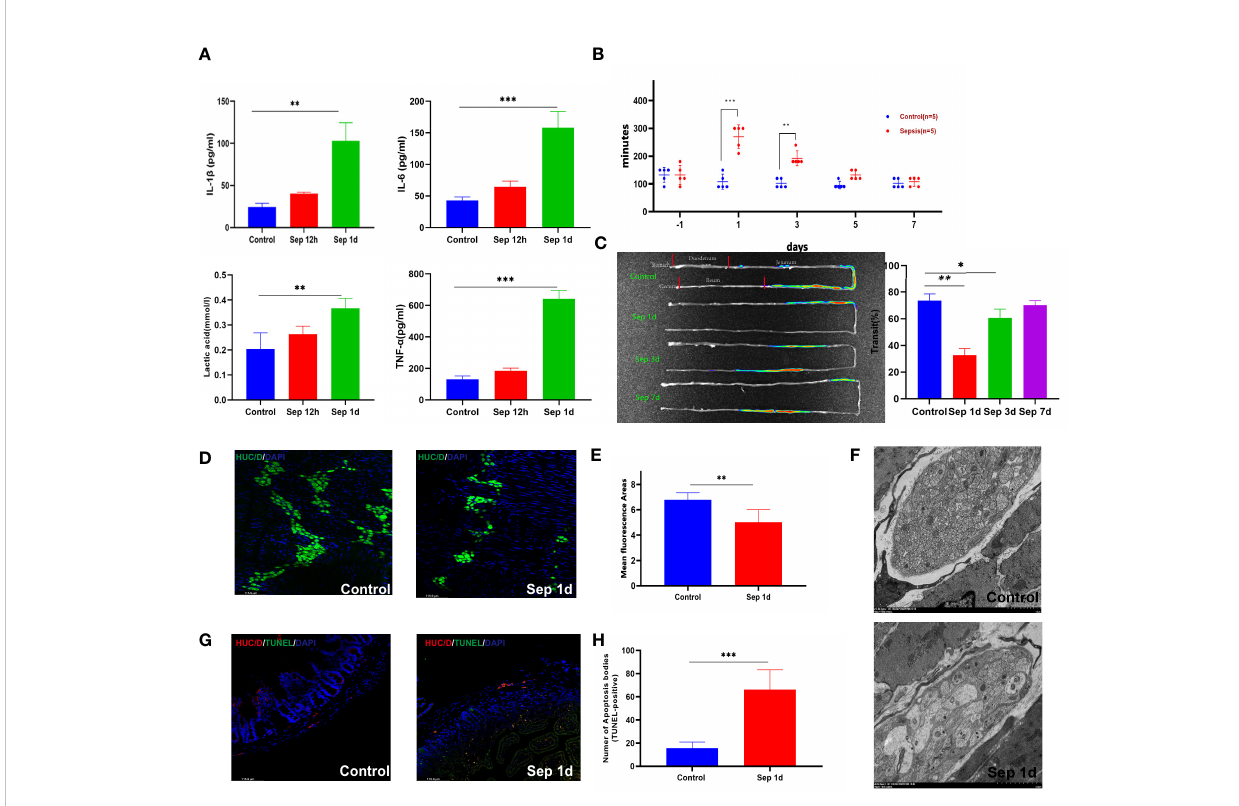
FIGURE 1 Changes after manipulation of Klebsiella pneumonia (KP)-sepsis mice. (A) Changes in plasma IL-6, IL-1 b , TNF- a , and lactate levels at 12 and 24 h after KP sepsis. (B) The carmine red experiment detected changes in intestinal transit time between the control and KP sepsis groups. (C) In vivo fl uorescence imaging of fl uorescein 5-isothiocyanate (FITC)-dextran visually displays intestinal motility changes and histograms of statistical results. (D, E) Control and sepsis 1 day after intestinal whole-mount HUC/D fl uorescent staining and statistical histogram of neuron fl uorescence area changes. (F) Transmission electron micrographs of mouse intestinal muscular layer neurons 1 day after control and KP sepsis. (G, H) Control and sepsis 1 day of intestine transverse HUC/D and terminal deoxynucleotidyl transferase dUTP nick end labeling (TUNEL) double fl uorescent staining and statistical histogram of neuronal apoptosis. Differences between groups were signi fi cant at a P value of <0.05. * Represents p <0.05, ** represents p <0.01, and *** represents